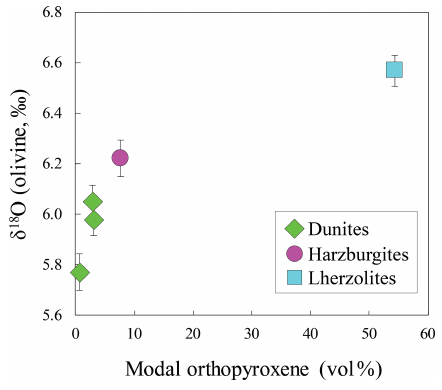
Figure 12. Plot of δ 18 O of olivine (weighted average ± 2 σ ) versus modal orthopyroxene for the Rocca d’Argimonia